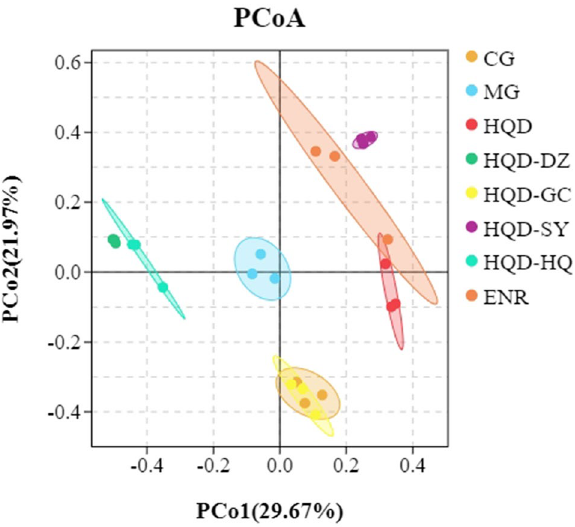
Figure 5. Analysis of intestinal microorganism of chicks were shown in the figure. CG, Control group; MG, Model group; DZ, jujube, Ziziphus jujuba ; HQ, Chinese skullcap, Scutellaria baicalensis ; GC, licorice, Glycyrrhiza glabra ; SY, white peony root, Paeoniae radix alba ; HQD, decoction consists of DZ, HQ, GC and SY; HQD-DZ, HQD absent of DZ; HQD-GC, HQD absent of GC; HQD-SY, HQD absent of SY; HQD-HQ, HQD absent of HQ; ENR, Enrofloxacin group. (The dosage of Chinese medicine was 500